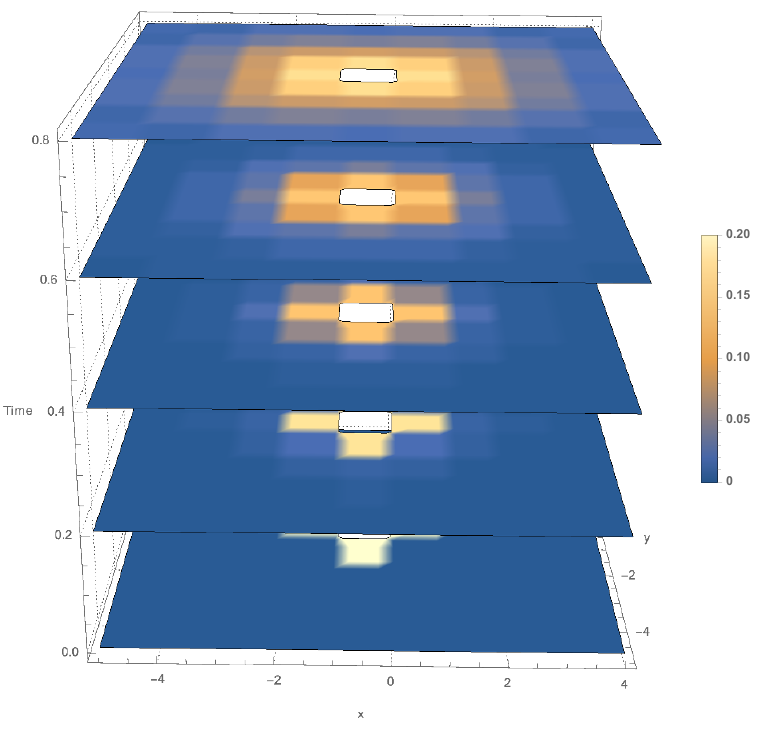
Figure 10 . Density plot of j T ij ( t ) j shown as a function of ( x; y ) at di(cid:11)erent time slices, where p p x = x i (cid:0) x j , y = y i (cid:0) y j with x i = mod ( i (cid:0) 1 ; L ) + 1, y i = ( i (cid:0) x i ) = L + 1 for the initial condition in eq. (3.13) with (cid:15) = 0 : 2, R = U = (cid:21) = 1 and L = 100. j T ij j (cid:24) 0 : 5 at ( x; y ) = 0 is not shown in the density plot to increase the contrast for the non-onsite bi-local